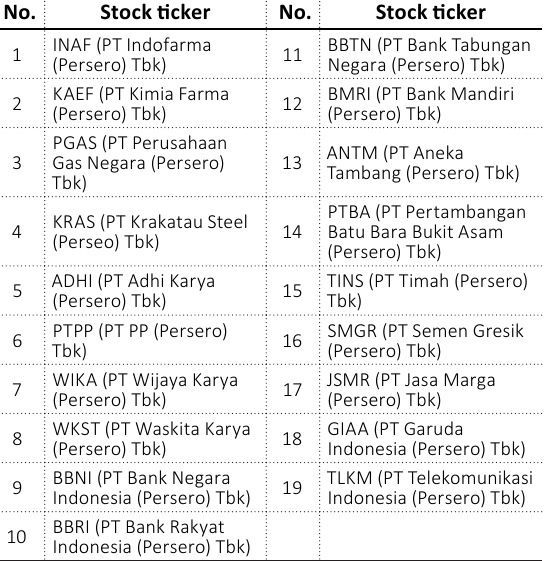
Table 1. Samples